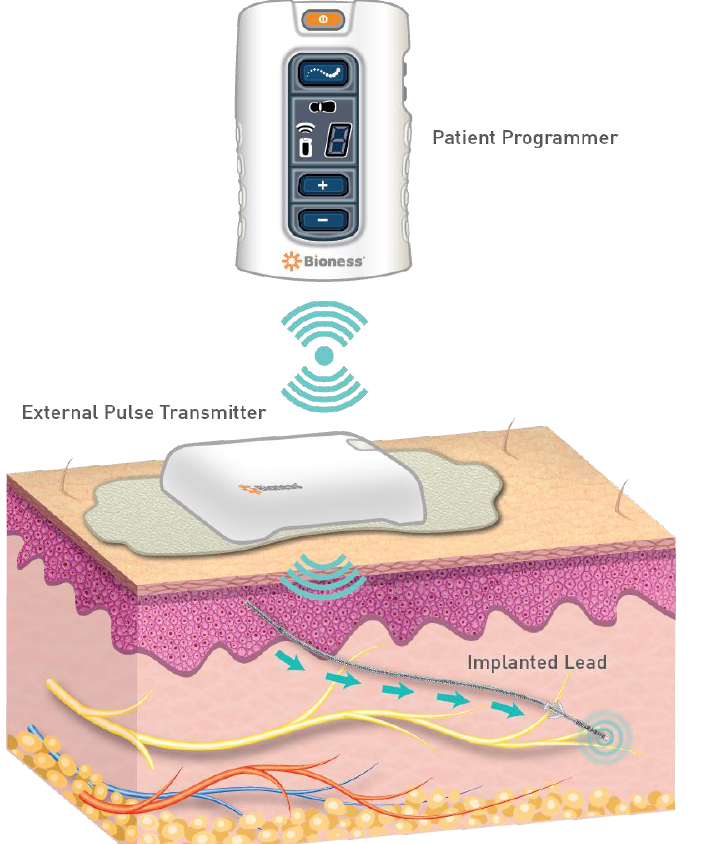
Figure 1. PNS is a system that applies electrical nerve stimulation by placing leads in close proximity to a named nerve. A pulse generator produces stimulation via the lead with the settings controlled by a patient via a programmer. The pictured example exhibits a Bioness Stimrouter PNS system (image courtesy of Bioventus).